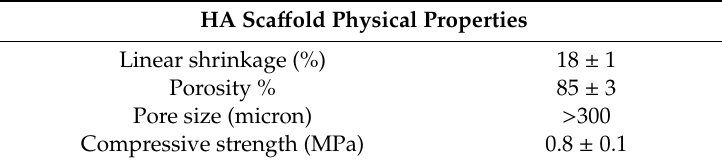
Table 1. The linear shrinkage, porosity, pore size and compressive strength of the HA sca ff